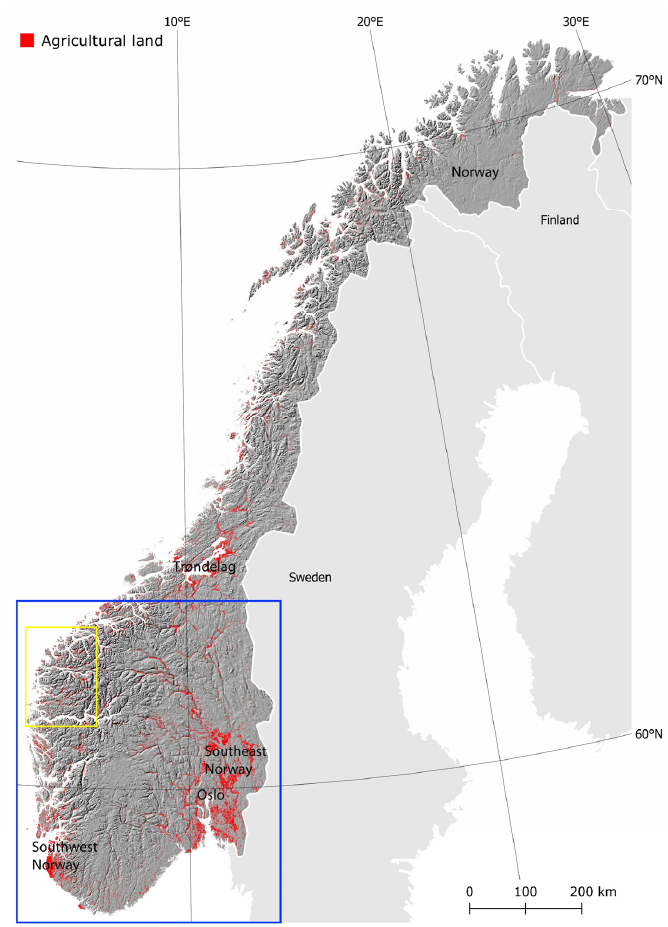
Figure 2. Study area covering terrestrial Norway (WGS84/UTM 33N). The map results are pro ‐ vided from two nested frames, southern Norway in 10 km grid squares (blue frame), and western south Norway in 5 km grid squares (yellow frame). Norway in 5 km grid squares (yellow